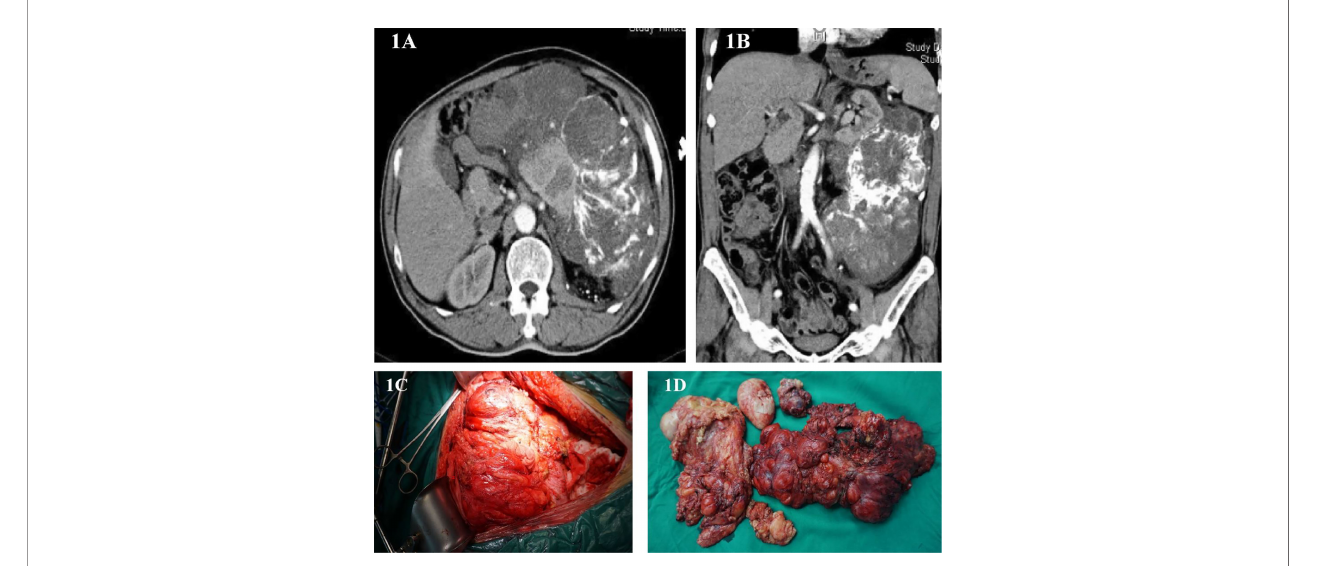
FIGURE 1 | (A, B) Abdominal image before the fi rst operation. (C) Intraoperative photos. (D) Surgical piece of the dedifferentiated